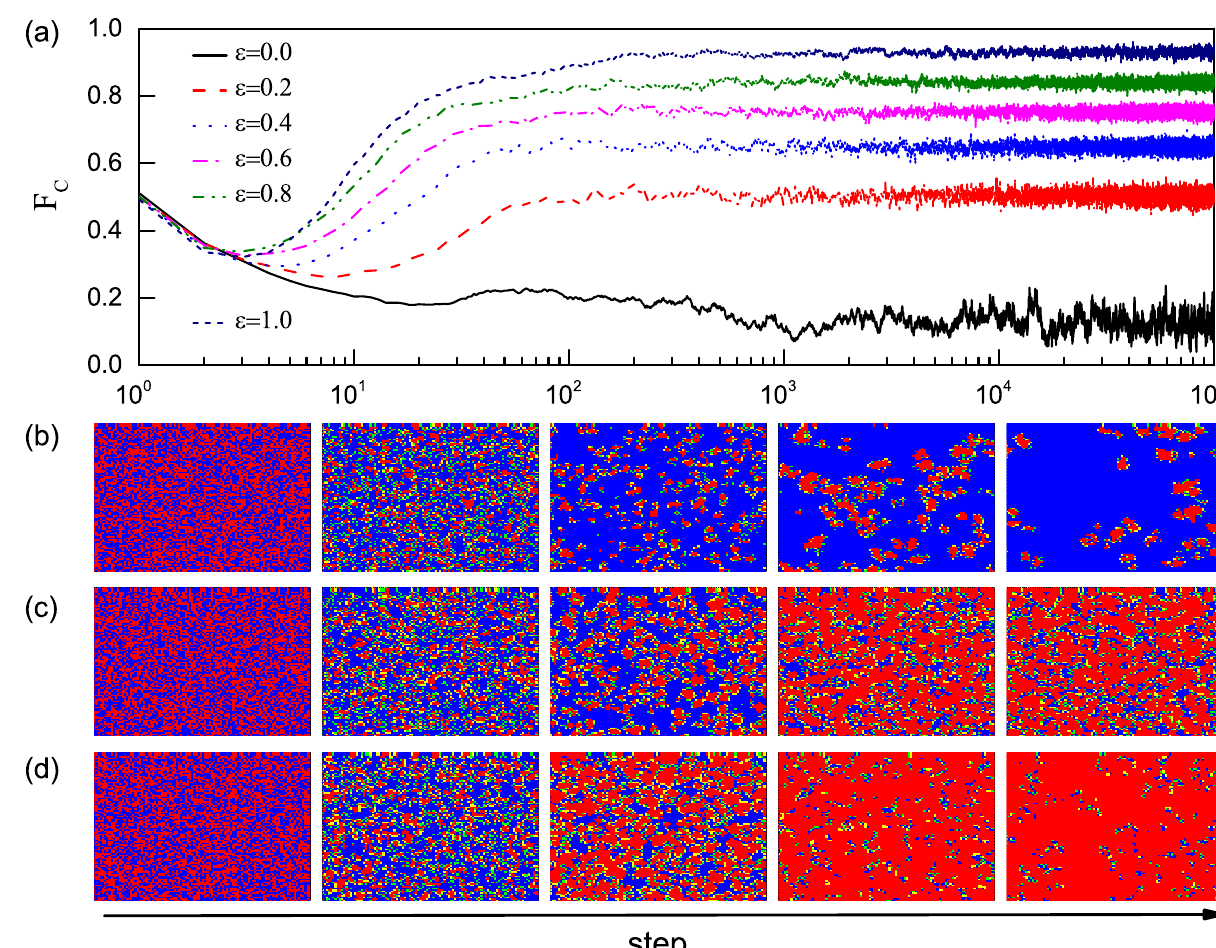
Fig 2. Time evolution of the fraction of cooperators and characteristic snapshots. (a) Time evolution of the fraction of cooperators F c for different strengths of the preferential selection ε . (b)–(d) Characteristic snapshots of the distribution of the different individuals on square lattices. Red and yellow are cooperators and blue and green are defectors. More specifically, yellow denotes a cooperator whose strategy in the last round was defection, while green denotes a defector whose strategy in the last round was cooperation. From (b) to (d), the values of ε are 0.0, 0.5, and 1.0, respectively. The game parameter b is fixed to